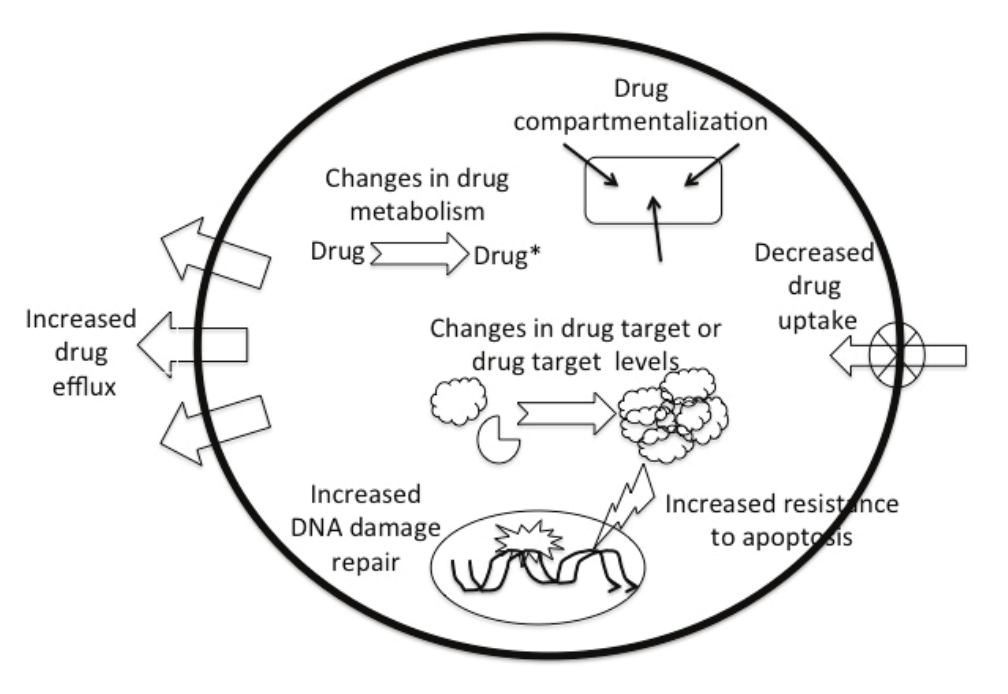
Figure 1. The major cellular drug resistance